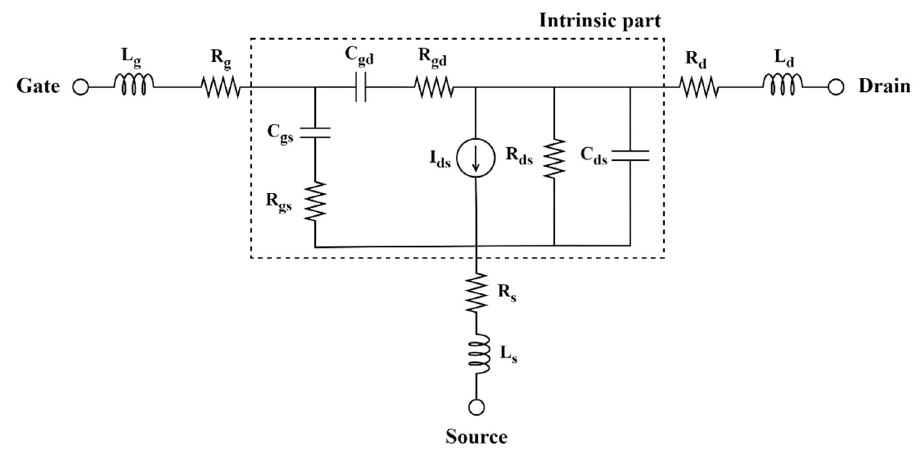
Figure 4. Small-signal equivalent circuit of HEMT. Table 3. Extracted small-signal parameters for extrinsic elements at drain voltage (V DS ) = 0 V and